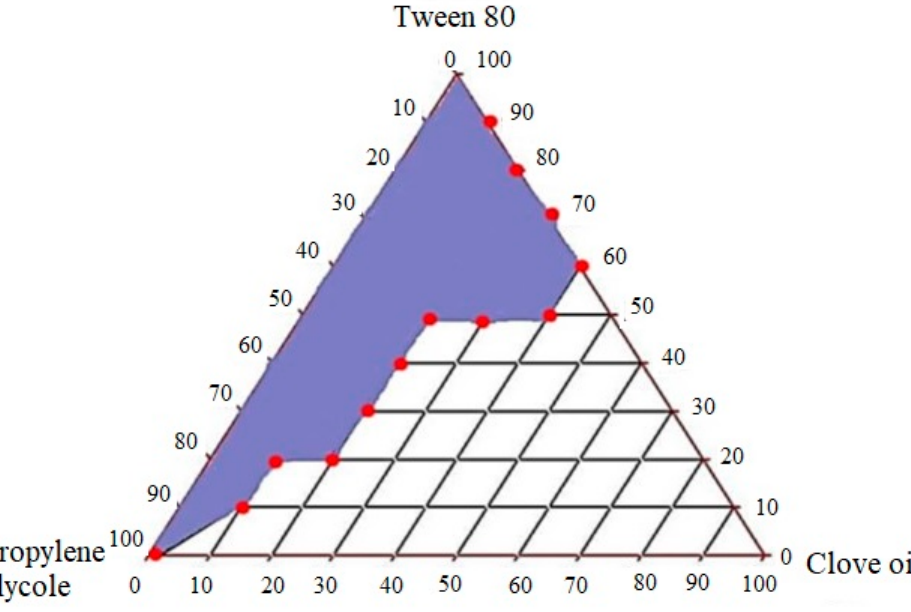
Figure 2. Construction of pseudo-ternary phase diagram with clove oil, Tween 80 and PG.